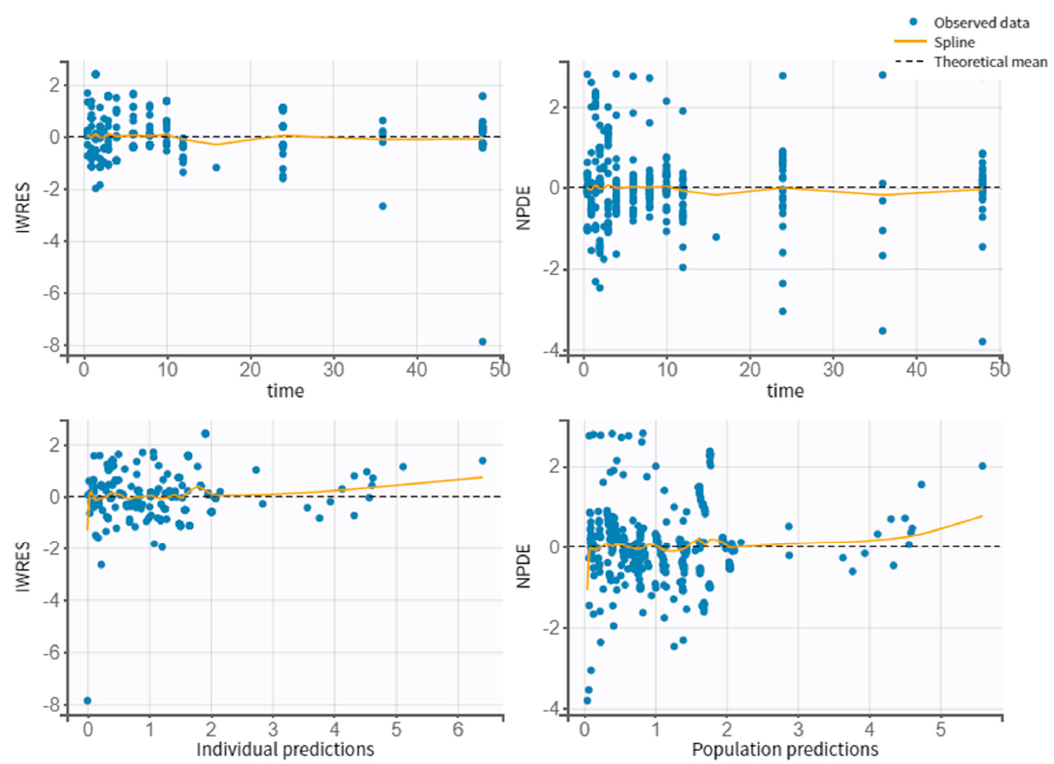
Figure 4. Individual weighted residuals (IWRES) and normalized predictive distribution errors (NPDE) versus time and the individual predicted concentrations.